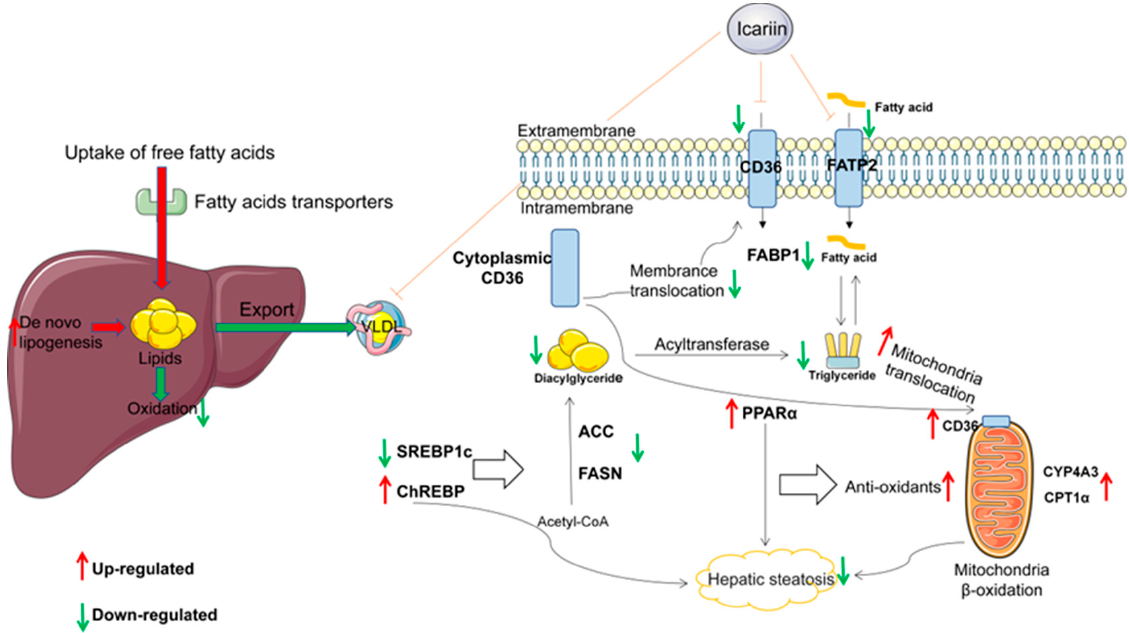
Figure 7. Diagrammatic representation for the mechanism of current explored study.